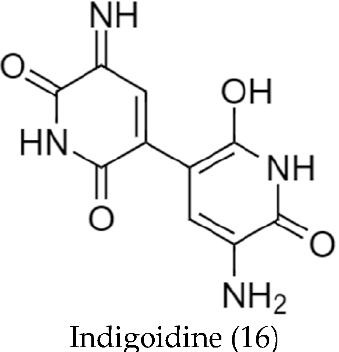
Figure 11. Chemical structures of indigoidine.